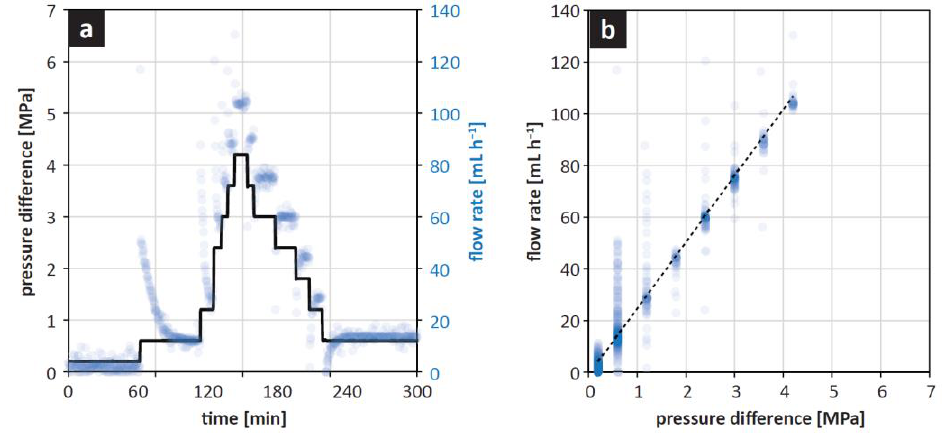
Figure 4. Results of initial, water-based flow measurements on sample SIL-1; ( a ) flow rate (in blue) and applied pressure difference (in black) versus time, ( b ) flow rate versus applied pressure difference, showing a linear dependence confirming laminar flow; the slope of a least squares fit line through these data has been used to estimate the initial permeability of the cemented coil sample.